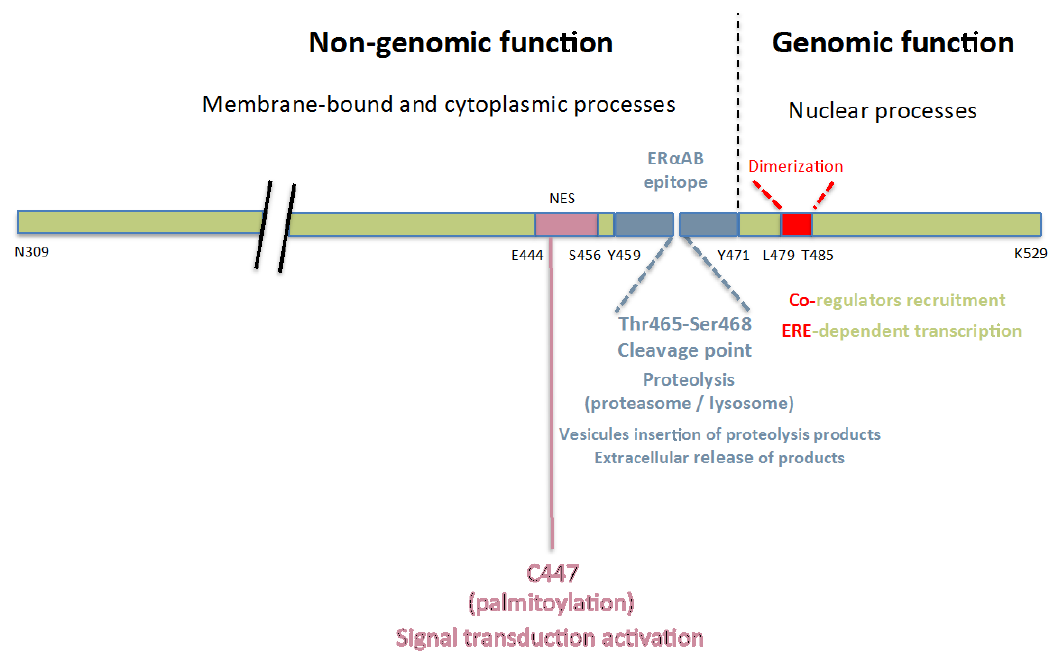
Figure 1. Schematic representation of the regulatory platform of the E 2 -binding core of ER α (N309-K529), postulated to mainly contribute to the onset of non-genomic and genomic responses induced by E 2 and ER α ABs. The ER α ABs’ epitope (Y459-E471) occupies a central, pivotal position localized between two motifs, each of them being implicated in one of these two types of responses (non-genomic, E444-S456; genomic, L479-T485). Functions of these three amino-acids sequences, as well as biological consequences resulting from E 2 /ER α ABs binding and consecutive activation of related inter-relationships between motifs of the platform are defined below (for details, see Section 3.3).